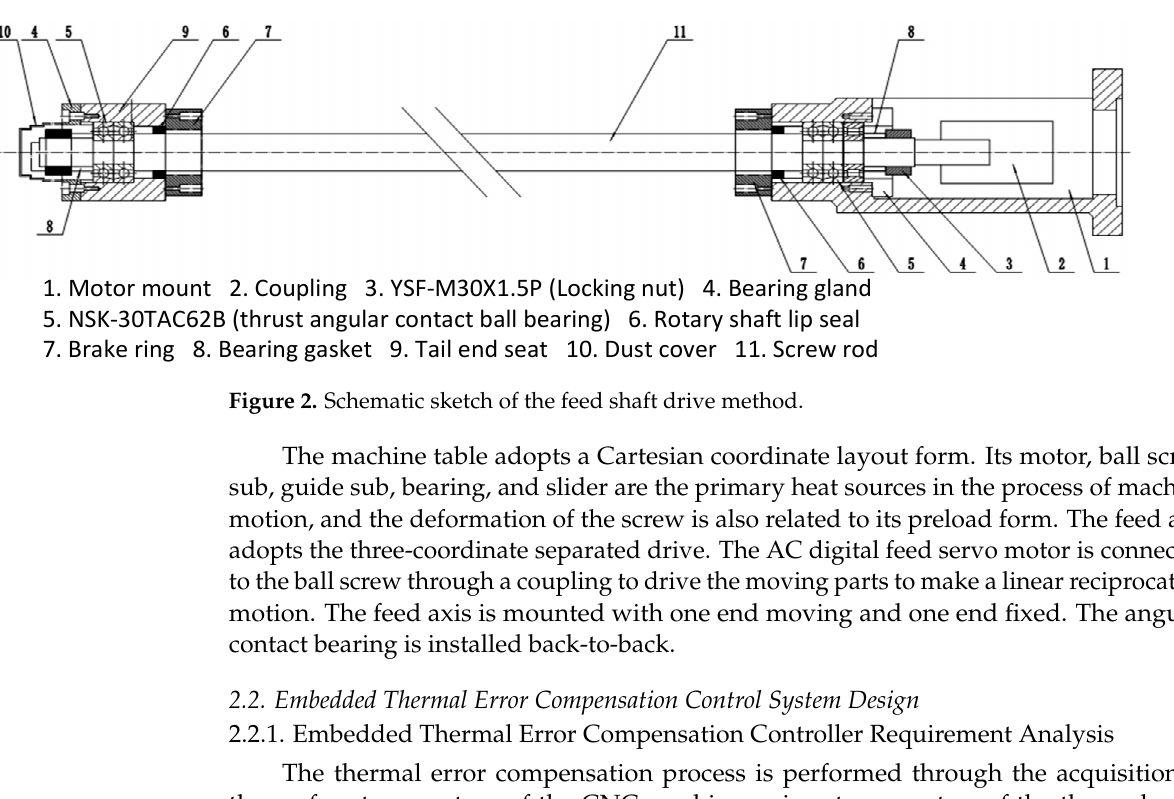
Figure 1. Vertical machining center VMC655H.